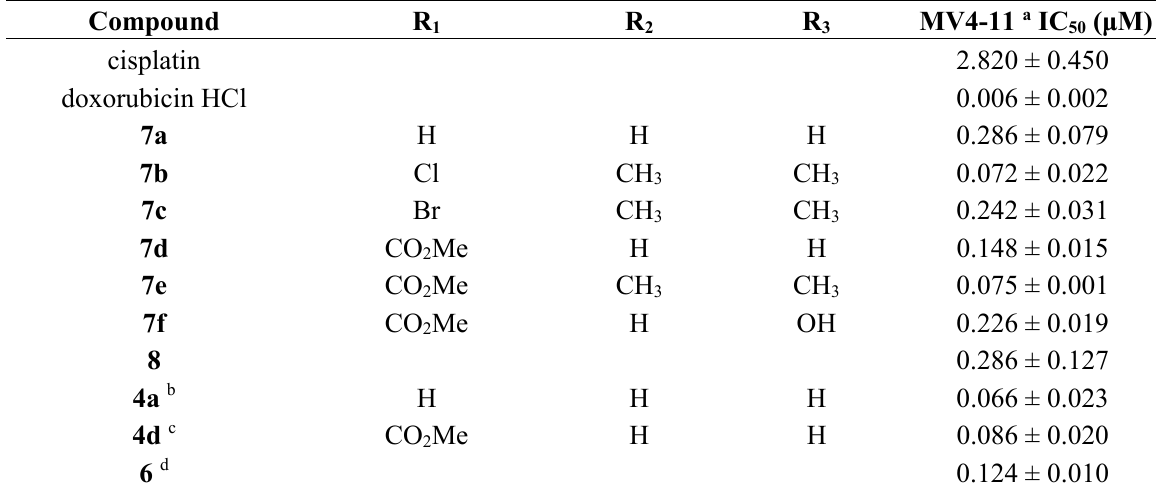
Table 1. Antiproliferative activity of the artemisinin-indoloquinoline hybrids against human leukemia MV4-11 cell line.